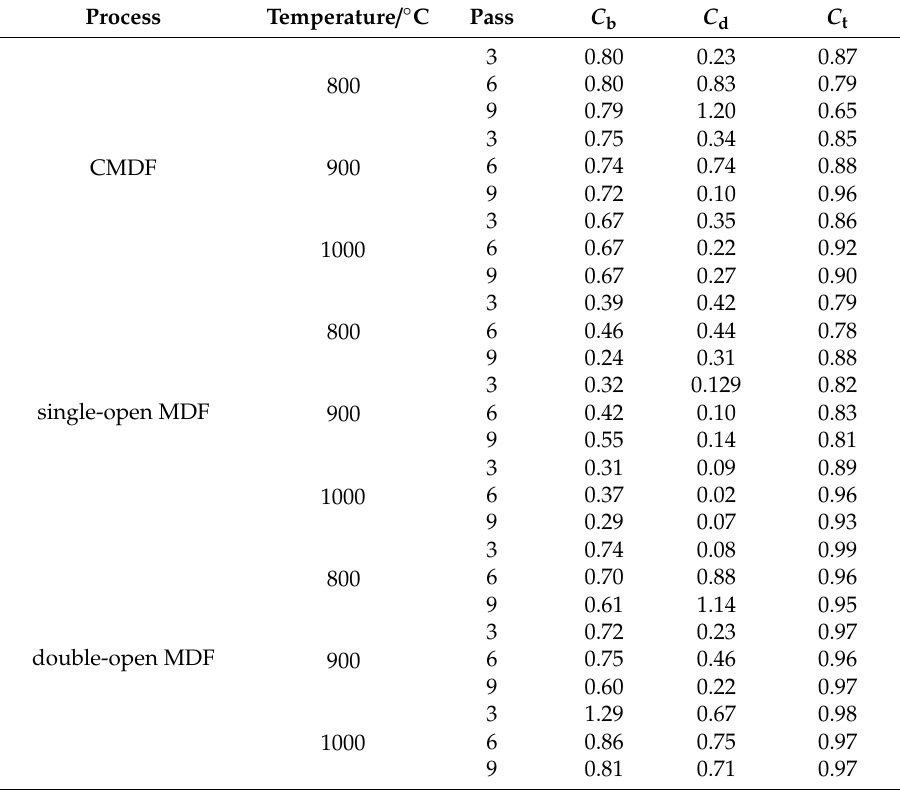
Table 2. Forging irregularity under di ff erent